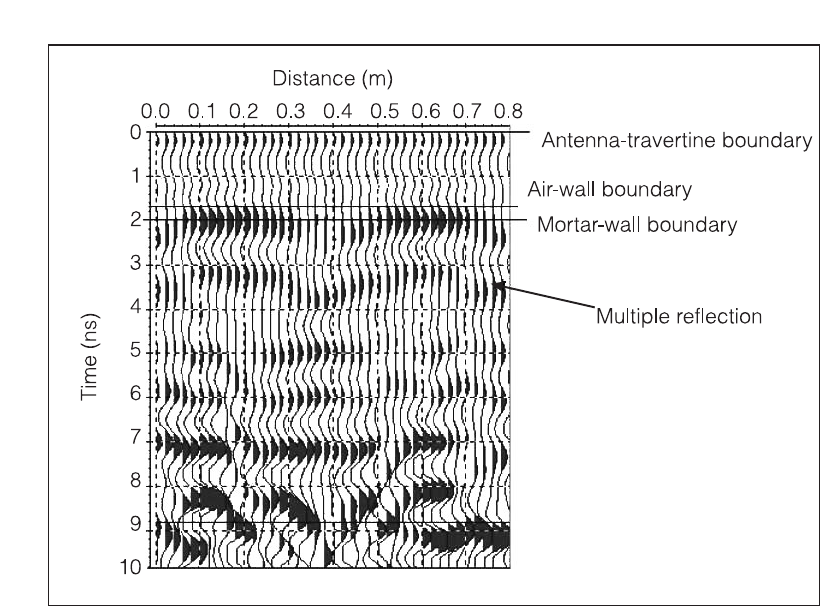
Fig. 4. Radar section related to the profile labelled A2 in fig. 3b.